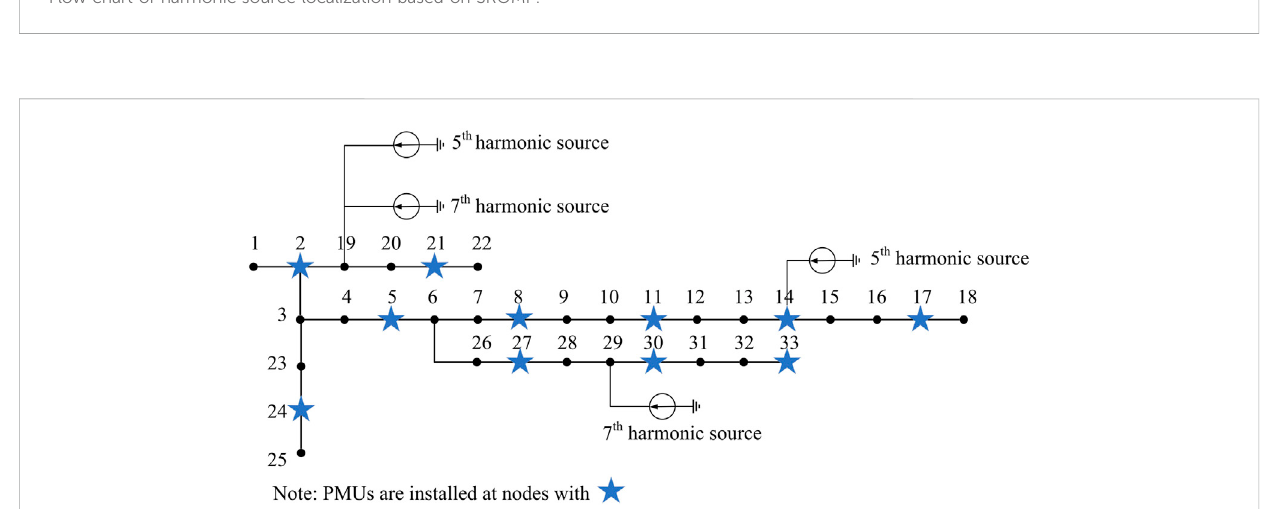
FIGURE 2 Flow chart of harmonic source localization based on SROMP.